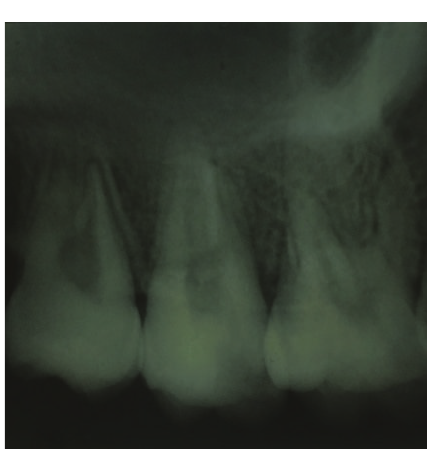
Figure 4: Preoperative radiograph of 27.